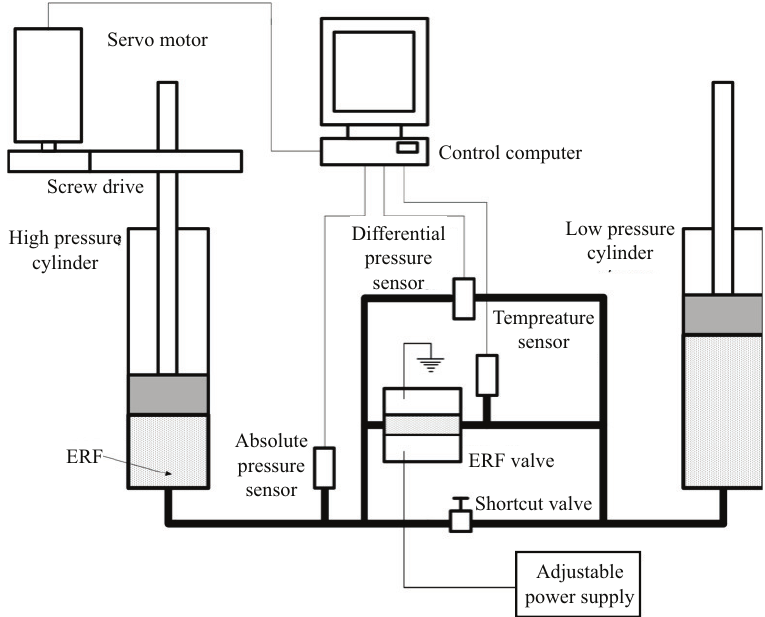
Figure 9. A schematic representation of the ERF test-bed is